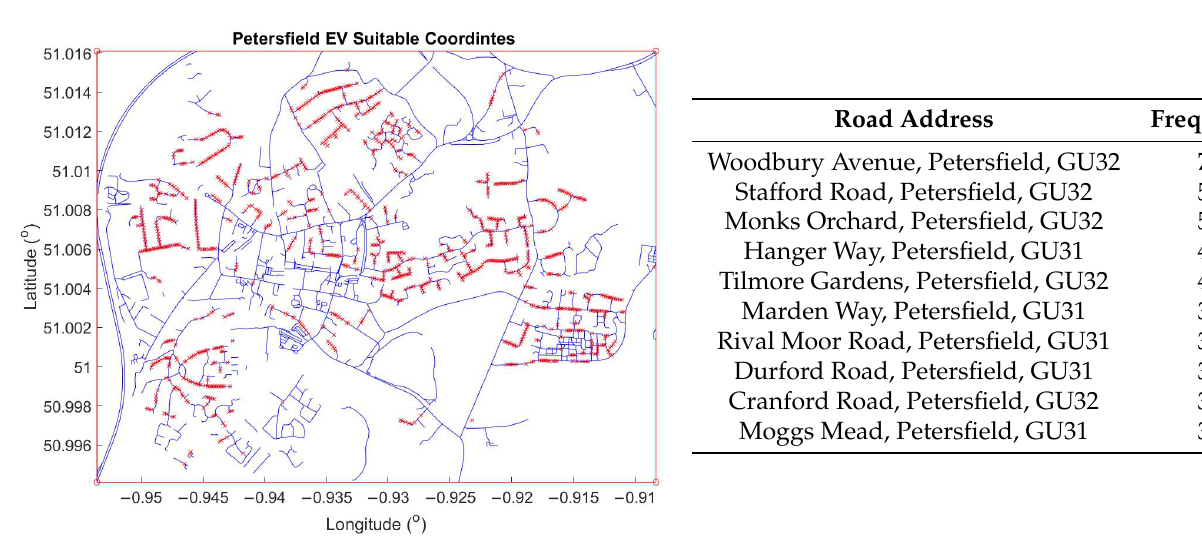
Figure 8. A plot of all coordinates within the Petersfield test area identified as suitable for EV charging ( Left ). A list of the top 10 roads most suitable roads for EV charging ranked by frequency of occurrences ( Right